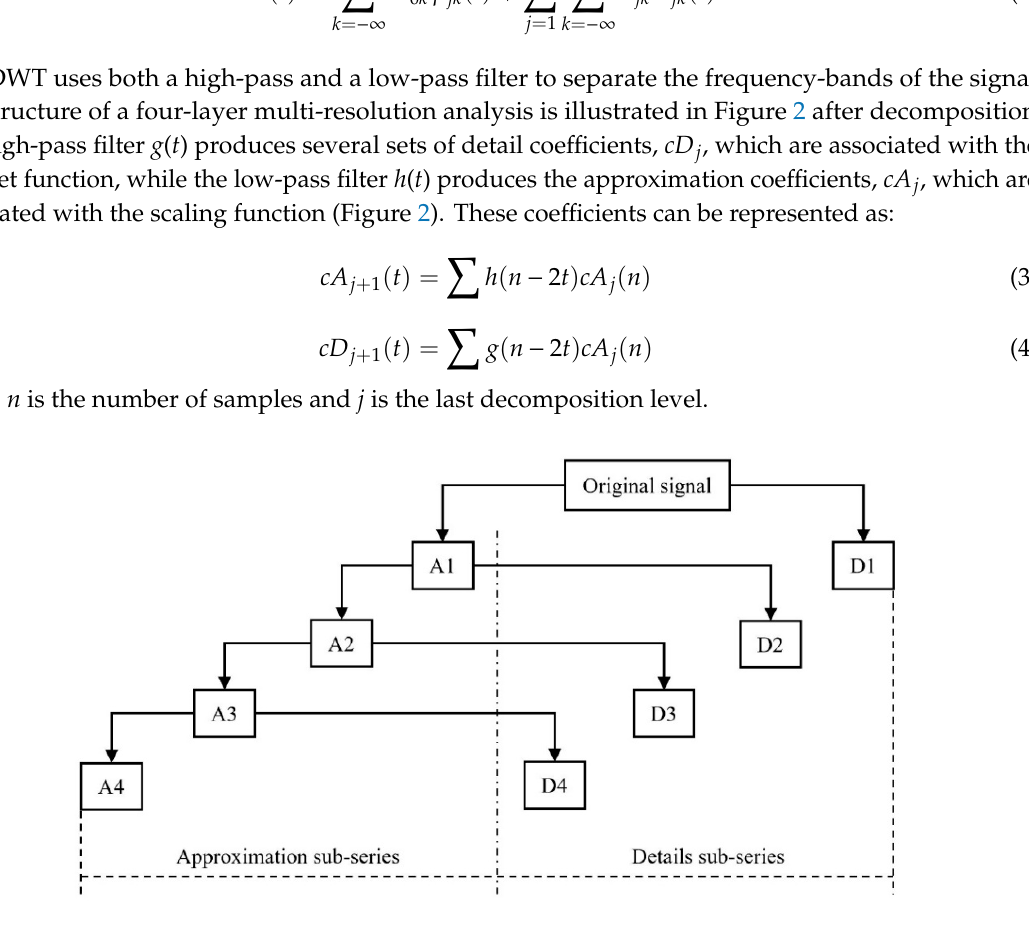
Figure 2. Parse tree structure of a four-layer multi-resolution wavelet analysis.